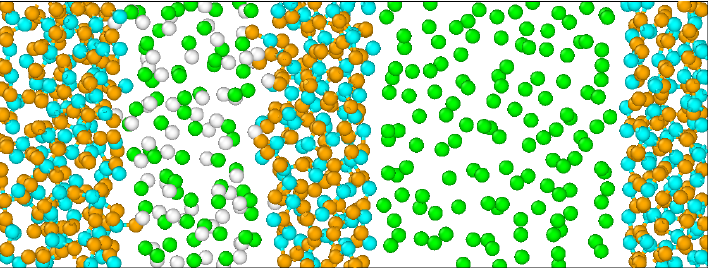
Figure 2. Last configurations of model A. (Green is chlorine, white is hydrogen, aqua is iron and